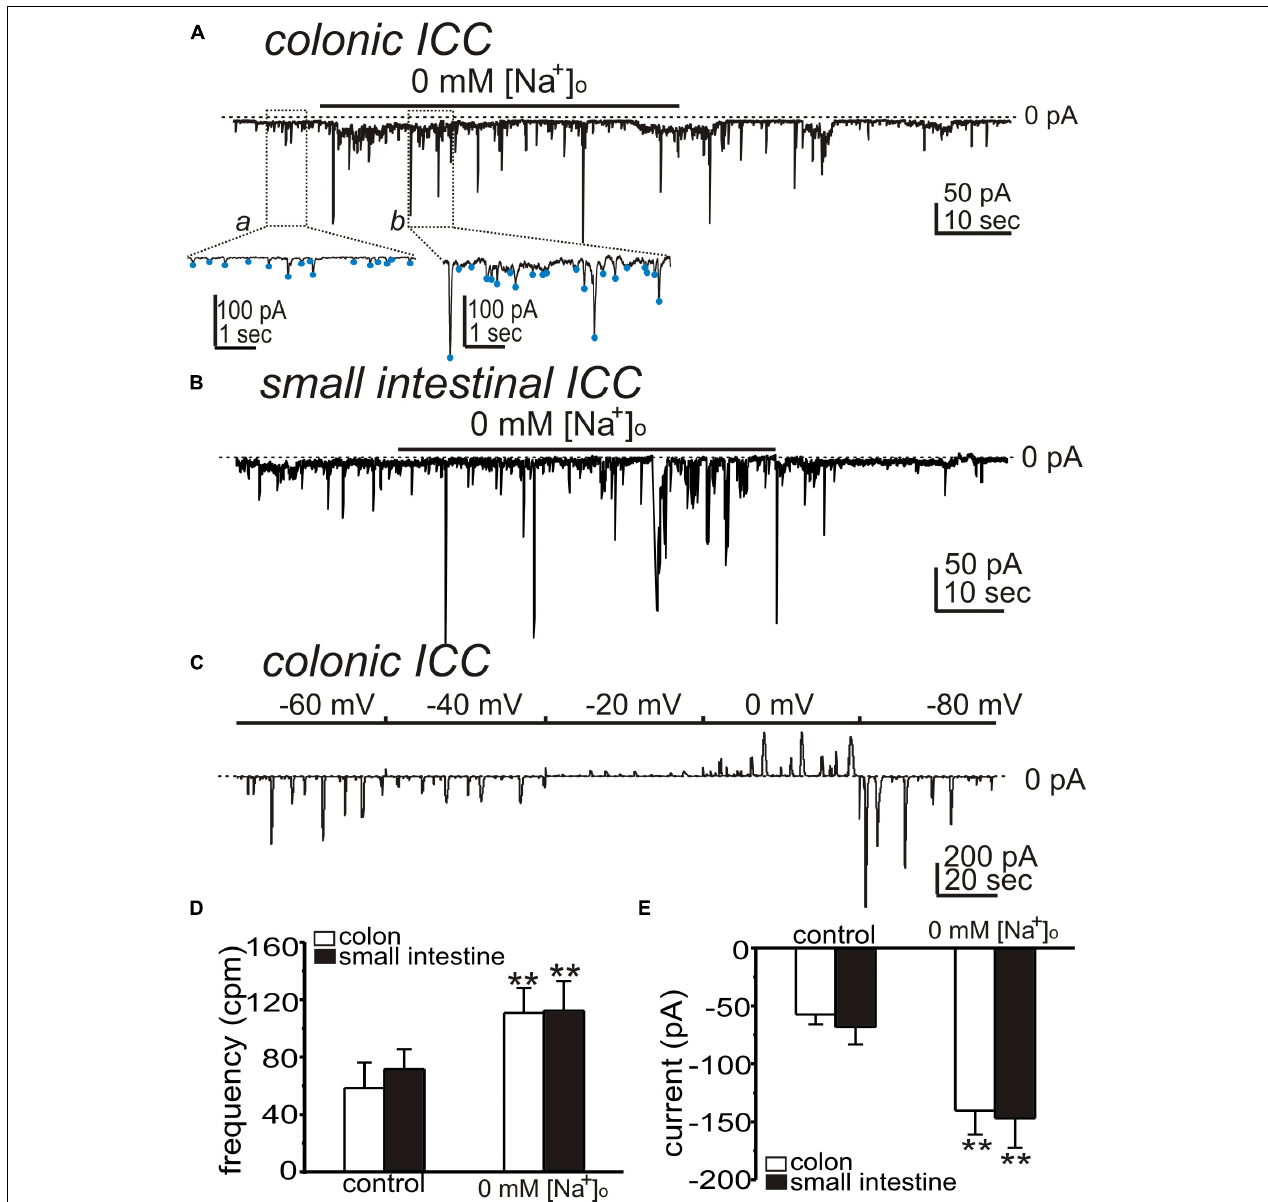
FIGURE 3 | Effects of low [Na + ] o on spontaneous transient inward currents (STICs) in ICC. (A,B) Representative traces showing that replacement of [Na + ] o (140 mM) with equimolar Li + (Solution II) increased the amplitude and frequency of STICs (holding potentials = –80 mV) in colonic (A) and small intestinal (B) ICC. Under control condition, the external solution was CaPSS (Solution I) and internal solution was Solution V (see Table 2 ). Insets show expanded time scale from upper panel (dotted boxes) to display how STIC amplitude and frequency were measured. Blue dots denote detection of STICs using event detection analysis (see section “Materials and Methods”). (C) Representative trace showing STICs at various potentials after 0 mM [Na + ] o in a colonic ICC. STICs reversed at about –29 mV (trace uncorrected for junction potential). Dotted lines denote 0 pA. (D,E) Summary data from five experiments shows the effects of low [Na + ] o on the frequency (D) and amplitude (E) of STICs (** p <